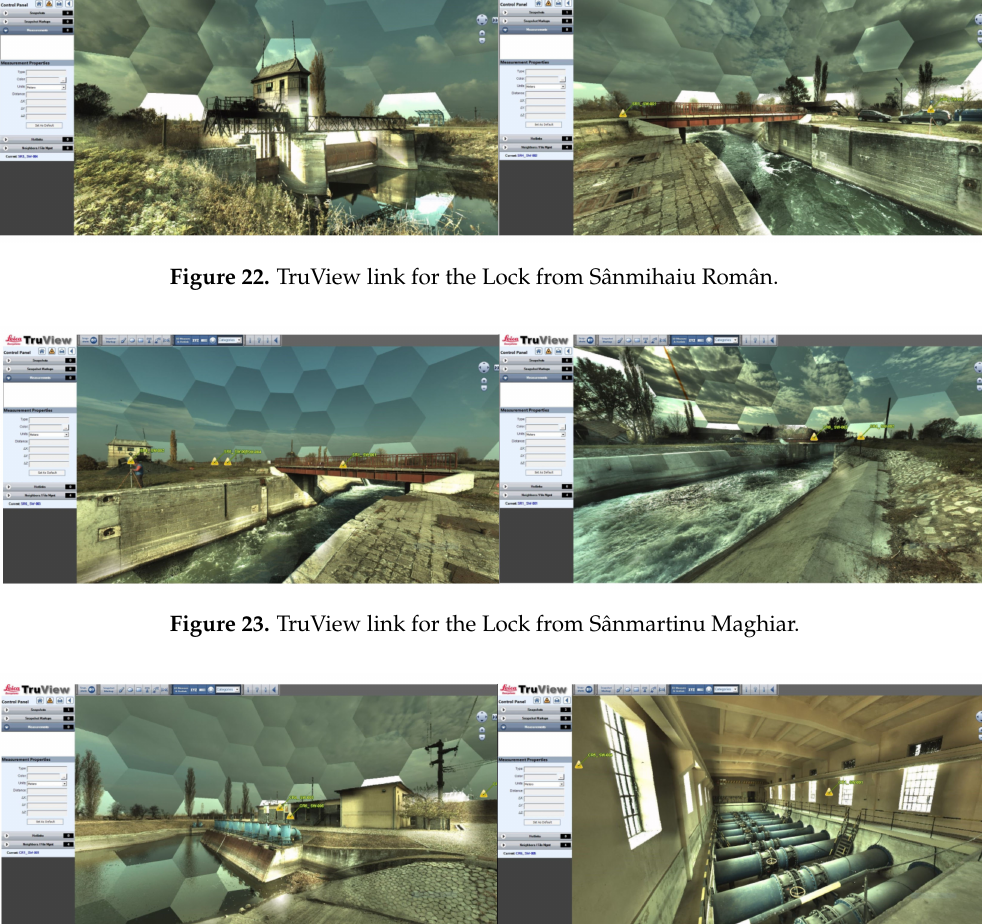
Figure 24. TruView link for Cruceni Pumping